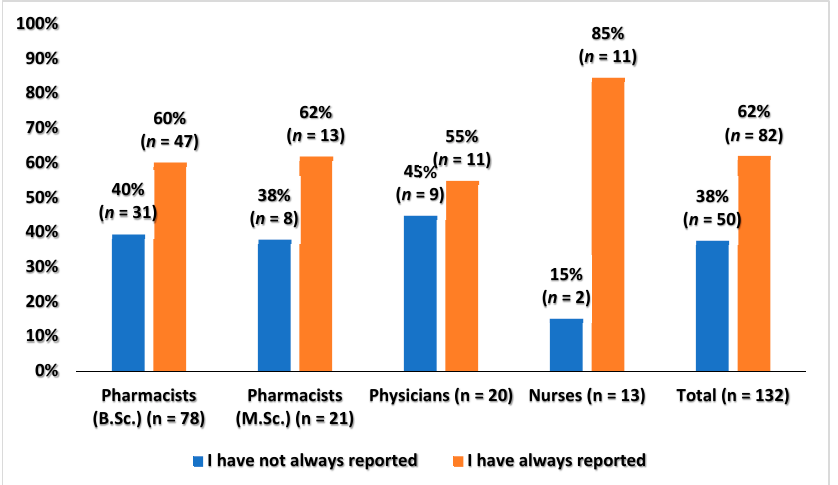
Figure 2. Healthcare professionals’ answer to the question of whether they had always reported suspected adverse drug reactions to the local health authority (Finnish Medicines Agency) or the marketing authorization holder when they became aware of them, percentage (%) of HCPs.